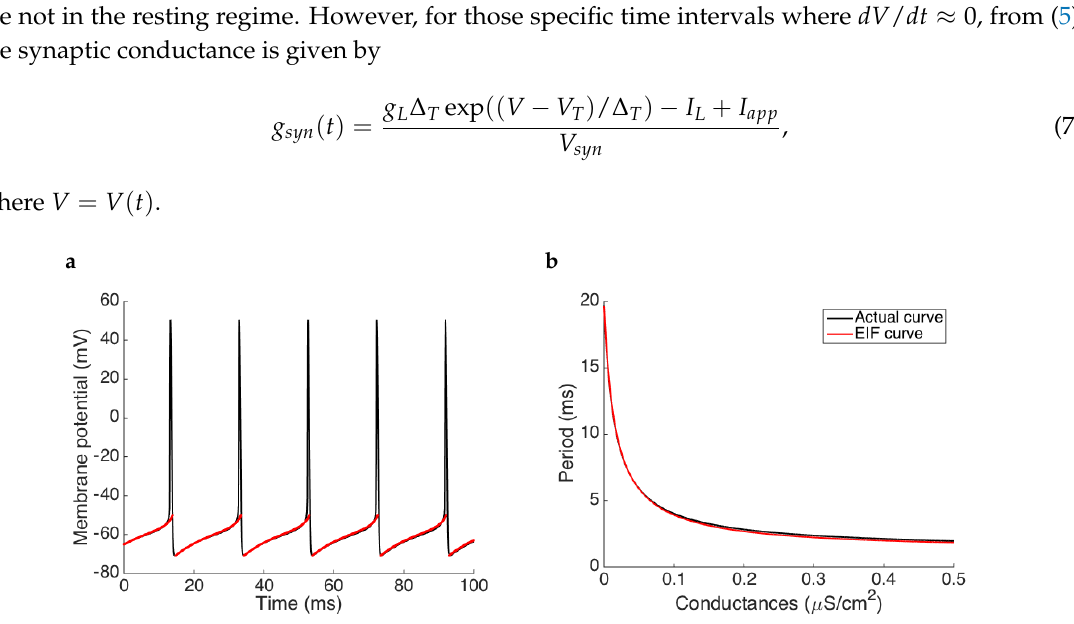
Figure 2. Approximation of the pyramidal cell model by the EIF model . Panel ( a ) shows the membrane potential trace obtained from the pyramidal cell model (black curve) given in Equation (1) when no synaptic input is considered, and the approximation of the membrane potential trace obtained by the EIF model (red curve) described in Equation (5). Panel ( b ) shows their respective T − g syn curve, where T is the period of oscillation (the black curve corresponds to the pyramidal case and the red curve to the EIF